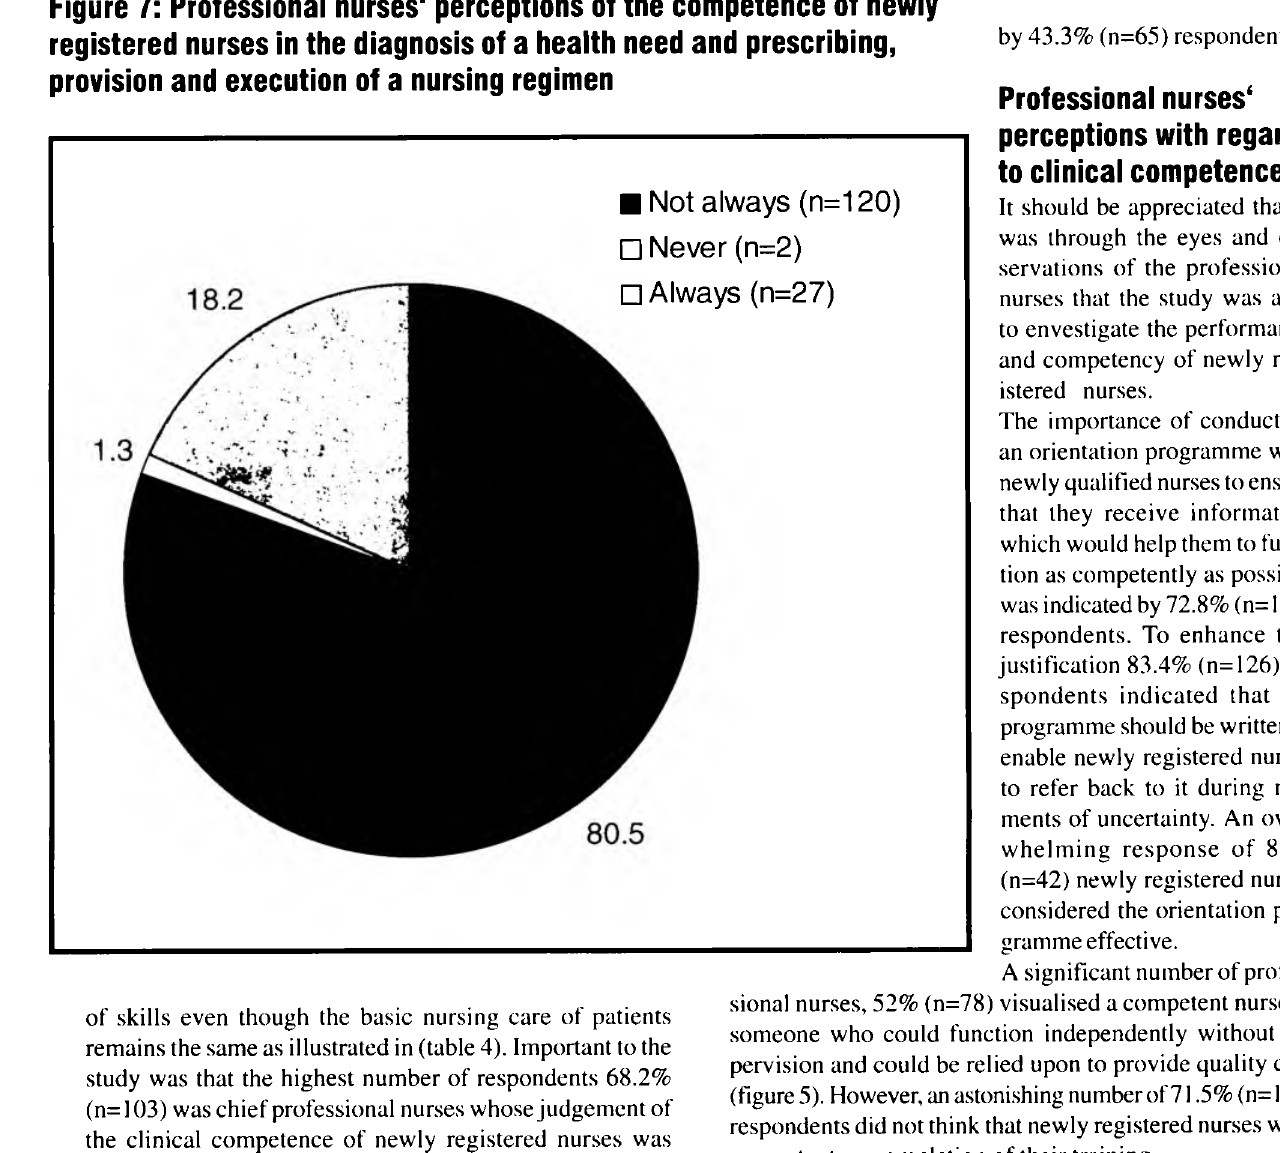
Figure 7: Professional nurses1 perceptions of the competence of newly registered nurses in the diagnosis of a health need and prescribing, provision and execution of a nursing regimen